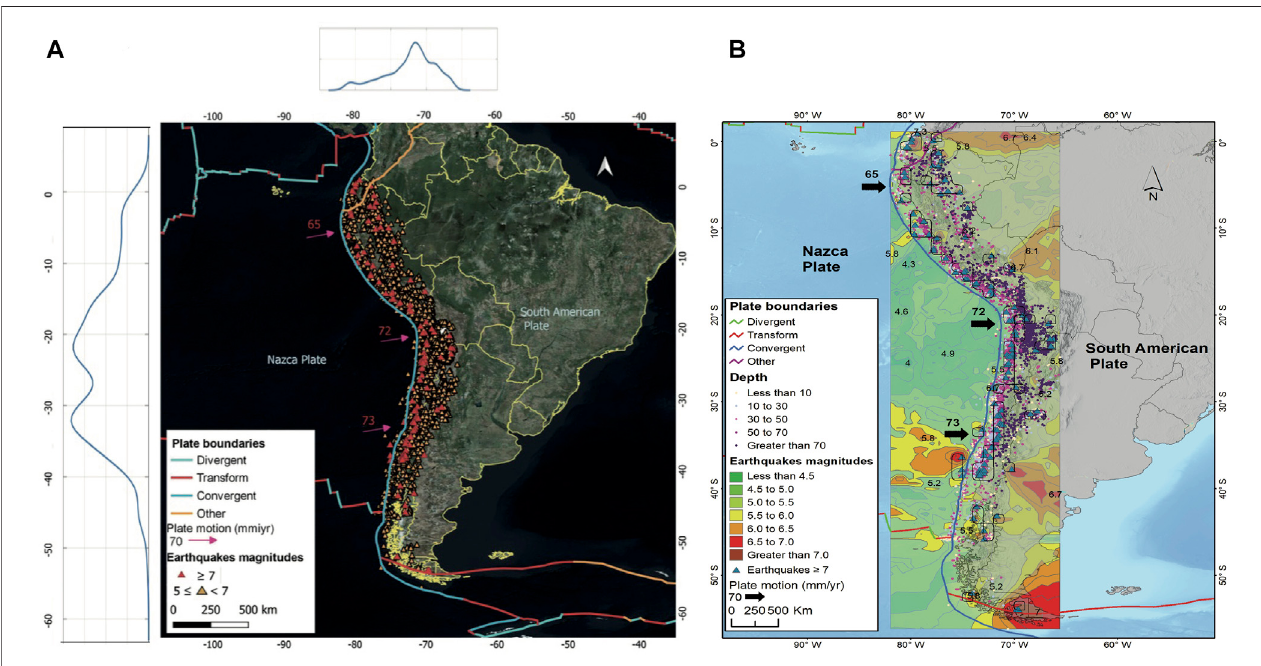
FIGURE 9 | Earthquakes in South America. (A) Seismic activity between 1900 and 2021 is shown as yellow triangles for 5 ≤ earthquakes magnitudes < 7. Earthquakes magnitudes ≥ 7 are marked with red triangles. Plate motion vectors (rotated based on the direction of plate movement), plate limits and earthquakes data were taken from the USGS. The PDF (probability density distribution) of the longitude and latitude shows that the seismic zone has a trimodal and quadrimodal distribution,respectively. (B) DistributionofseismichazardsinSouthAmerica.Thespatialprobabilityofoccurrencefor5 ≤ earthquakesmagnitudes < 6isshownin shades of green; for 6 ≤ earthquakes magnitudes < 7 is shown in shades of orange; and for earthquakes magnitudes ≥ 7 is shown in shades of